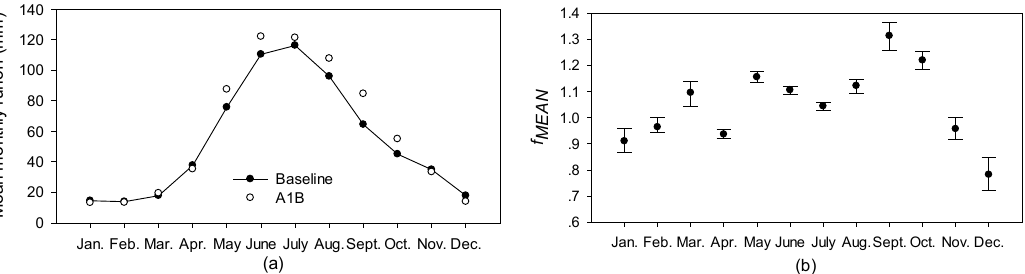
Fig. 3 Monthly mean air temperature and precipitation in the West River basin under baseline (1961 to 1990) and A1B (2011 to 2040) scenarios.